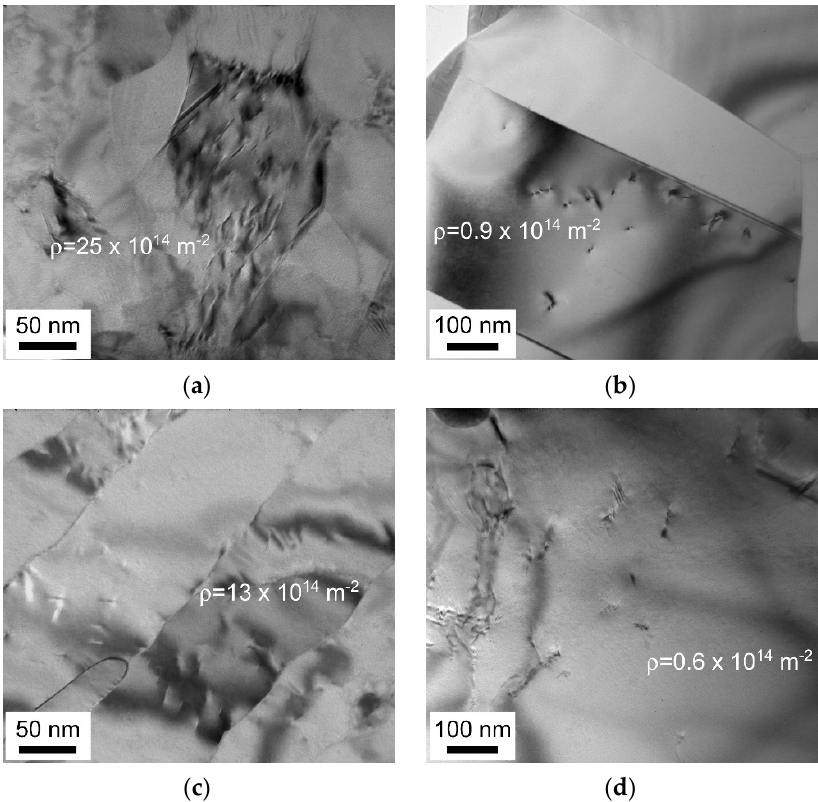
Figure 4. Representative transmission electron microscopy (TEM) images of dislocation substructures (with corresponding dislocation densities) that remained in a 316L-type stainless steel after cold ( a , b ) or warm ( c , d ) rolling and 30 min annealing at 973 K ( a , c ) or 1073 K ( b , d ).